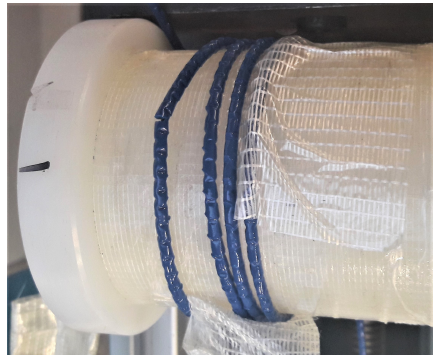
Figure 5. Impact of the radiation on the cable: radiation reduces the elasticity of the plastic, causing cracks when